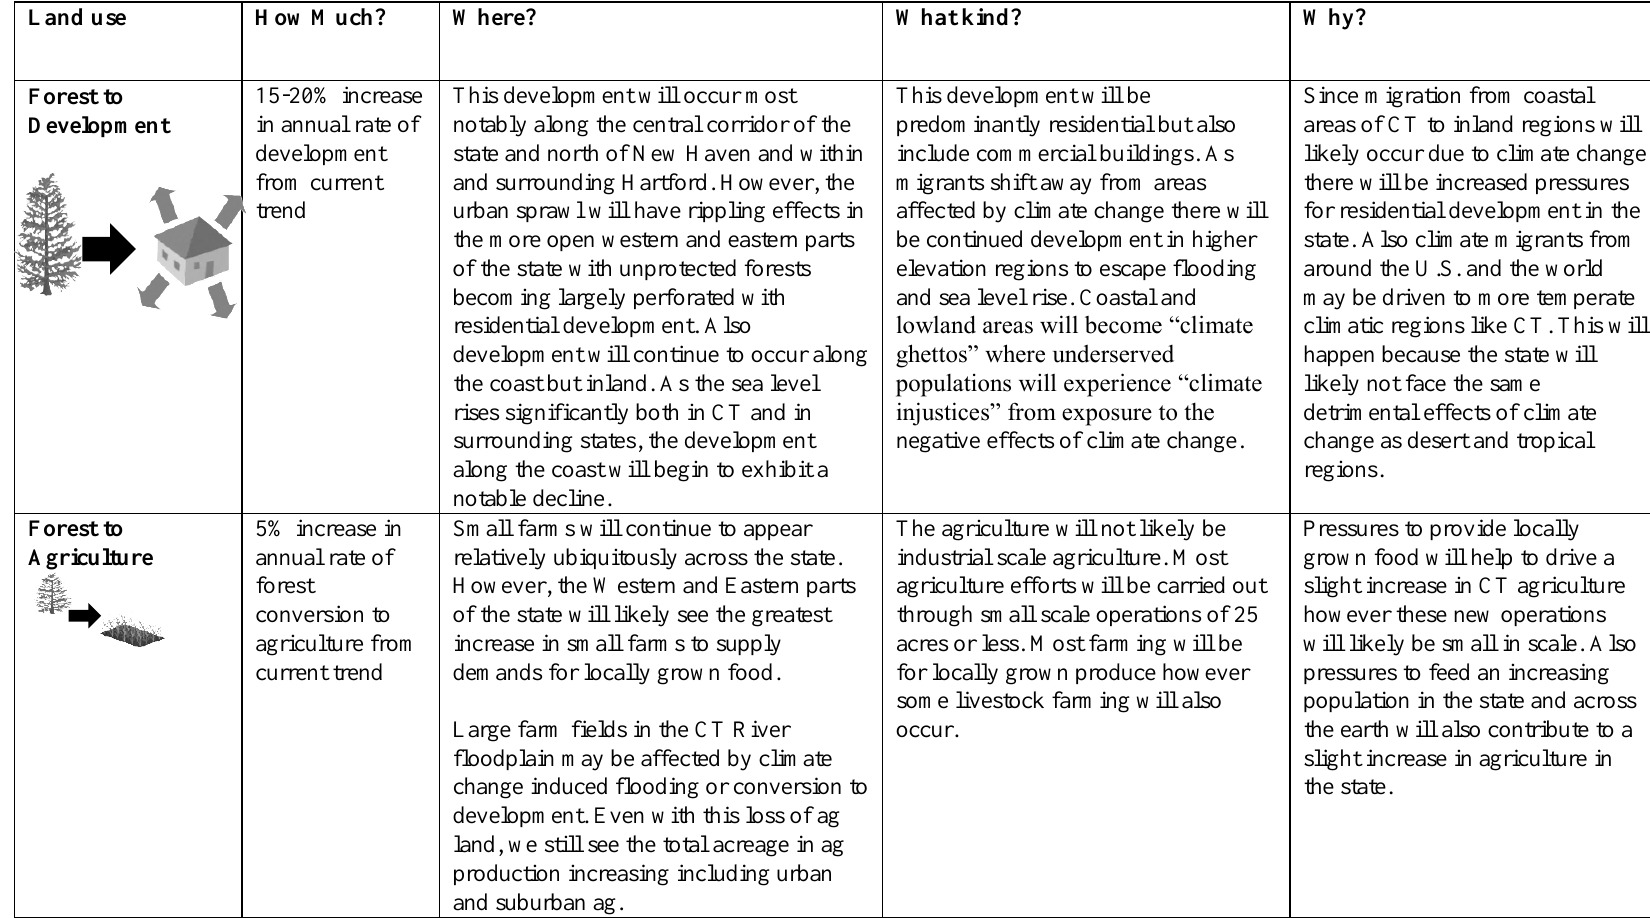
Table A2.13. Scenario 1: Hartford Default Rising